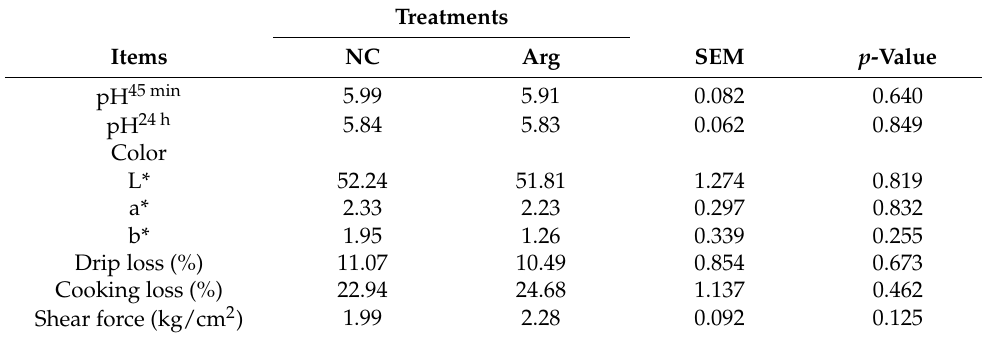
Table 6. The effects of in ovo feeding of L-arginine on meat quality of slow-growing chickens on day 63.